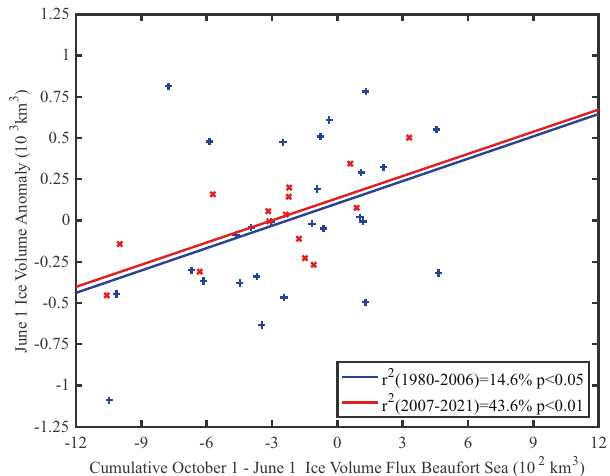
Fig. 8 Relationship between cumulative cool season ice volume fl ux into the Beaufort Sea region and June 1 Beaufort Sea ice volume 1980 – 2021. Scatterplot of the cool season (October 1 - June 1 following year) PIOMAS ice volume fl ux and June 1 PIOMAS ice volume anomaly. Linear least squares fi t to the data for the two regimes are also shown as are the percentage of the variance explained. The ice volume time series has been detrended by step functions with a breakpoint in